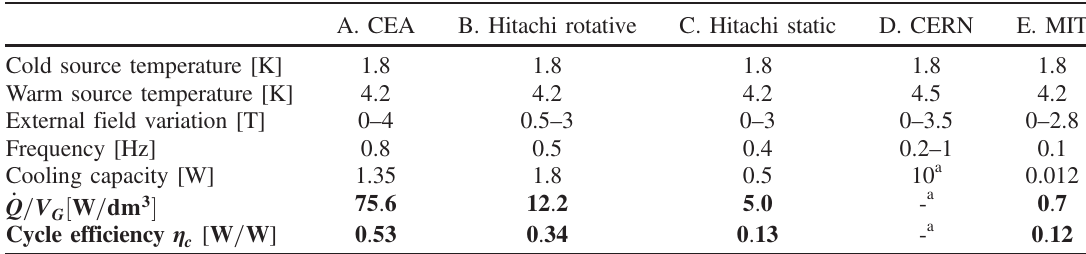
TABLE I. Comparison of various technical solutions.